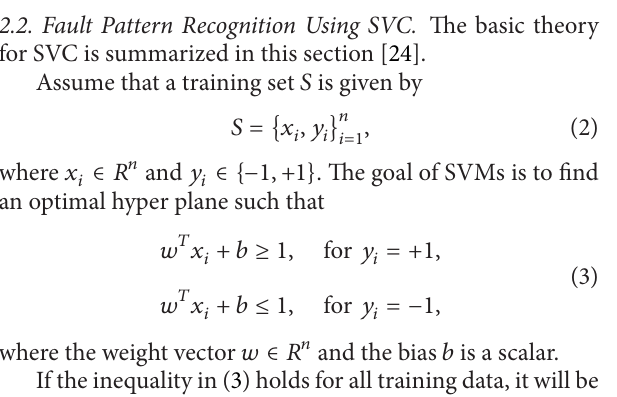
Figure 9: The MFS-MG experimental